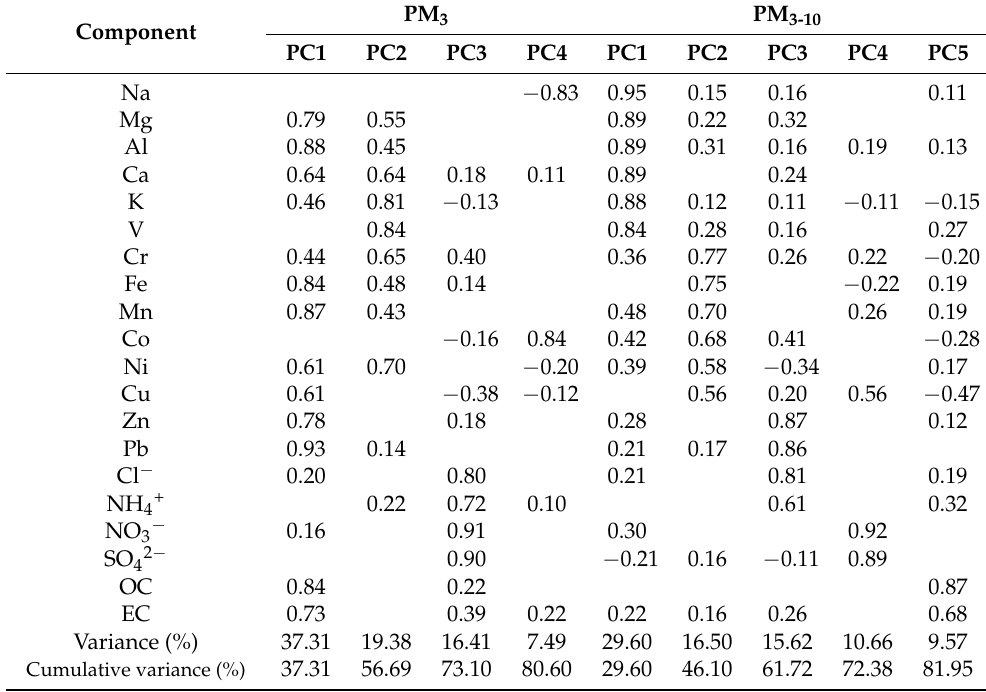
Table 1. PCA for TEs, WSIs, OC, and EC in PM 3 and PM 3-10